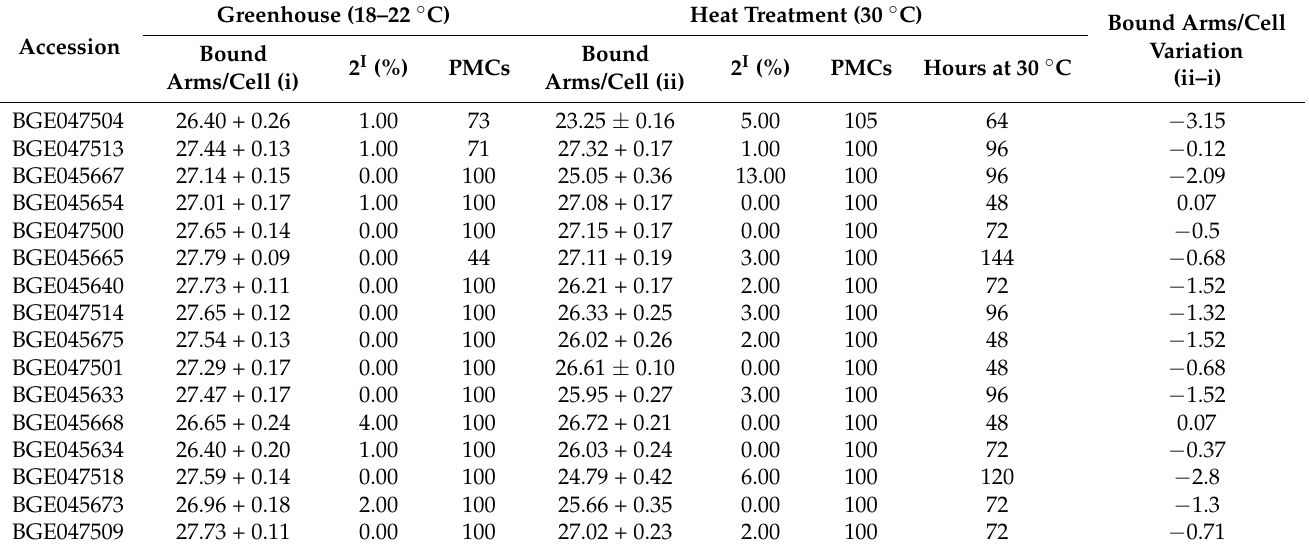
Table 2. Metaphase I observations. Number of bound arms per cell, percentage of cells with two univalents (2 I ), and variation in the number of bound arms per cell in plants of 16 Spanish landraces of T. turgidum grown during meiosis either in the greenhouse at optimum temperature range (18–22 ◦ C) or in a climatic chamber at 30 ◦ C. Hours of the temperature treatment are also